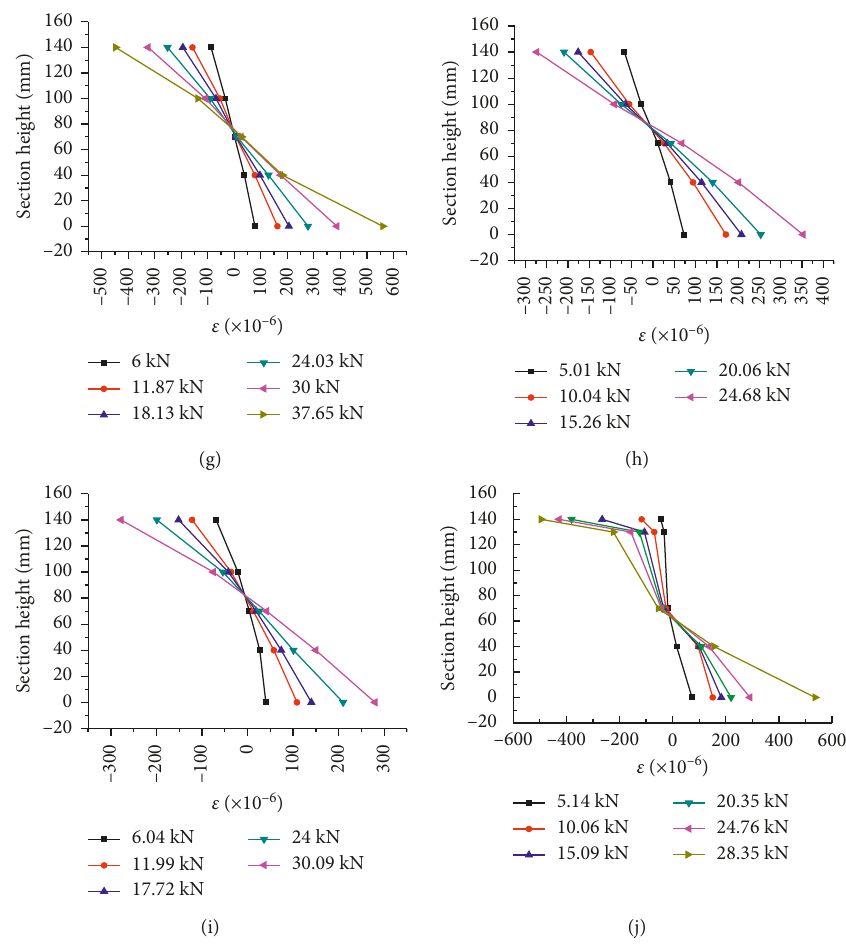
Figure 37: Sectional strain variation at the midspan: (a) B-1; (b) GB-1; (c) GB-2; (d) GB-3; (e) GB-4; (f) GB-5; (g) GB-6; (h) CB-1; (i) CB-2; (j)